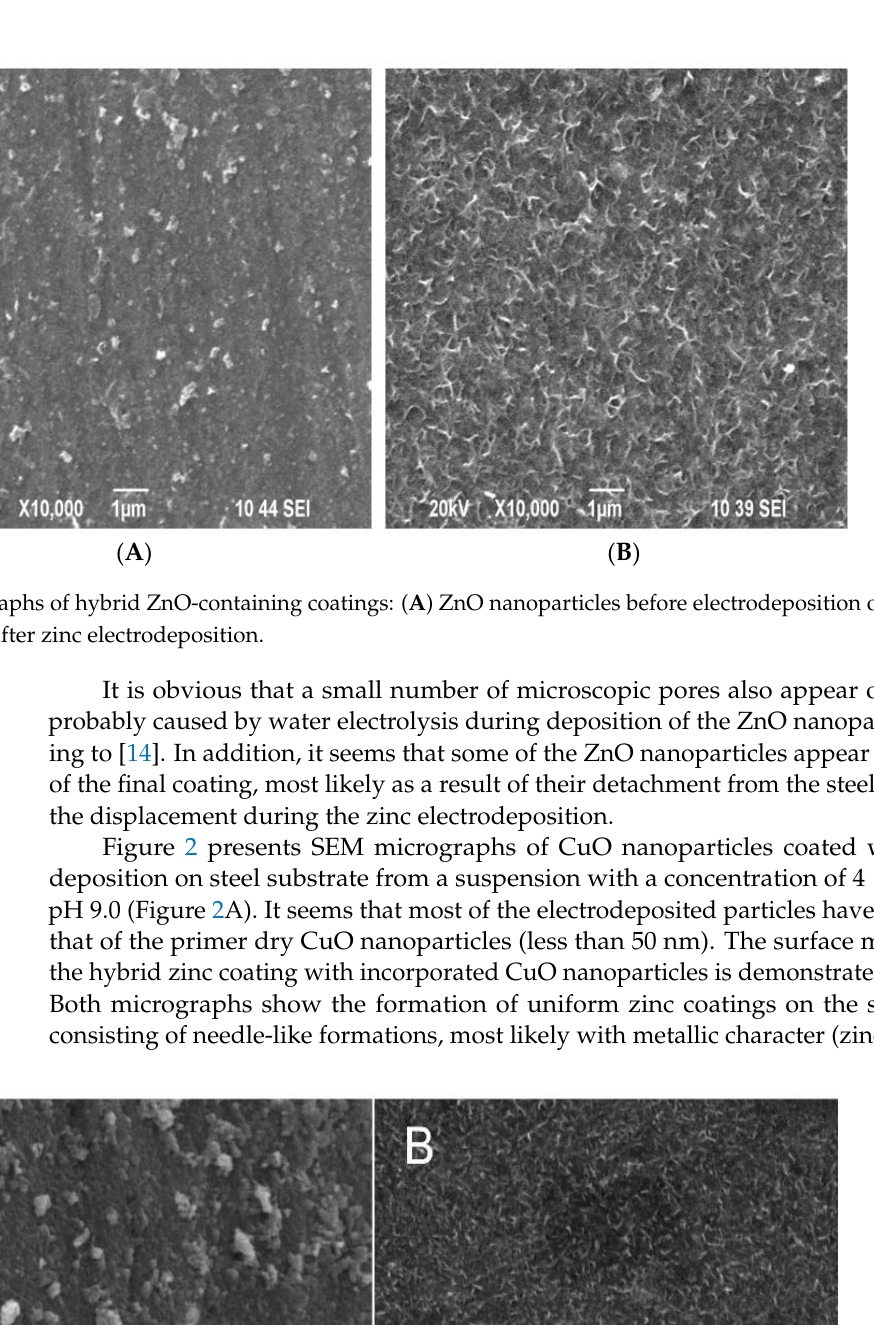
Figure 2. SEM micrographs of hybrid CuO-containing coatings: ( A ) CuO nanoparticles before electrodeposition of ordinary zinc; ( B ) final coating after zinc electrodeposition.